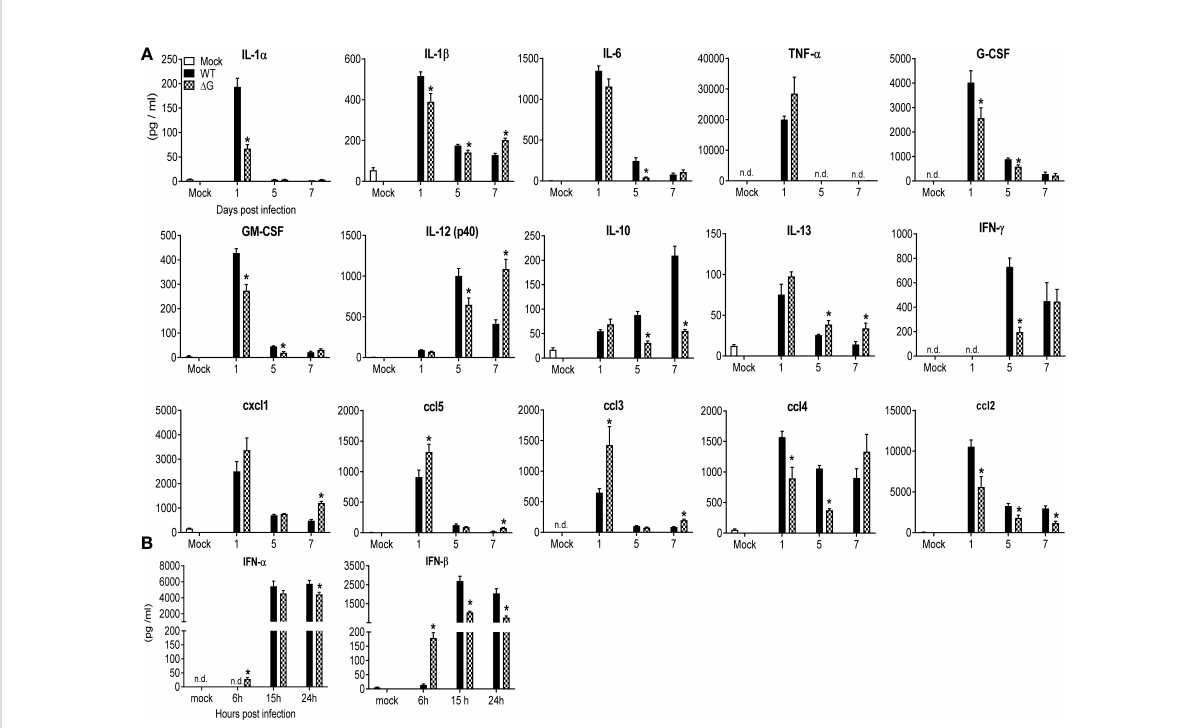
FIGURE 2 BAL fl uid levels of pro-in fl ammatory cytokines, chemokines and type I IFNs. Mice were either infected with rhMPV-WT or - D G or mock infected and sacri fi ced at various time points p.i. to collect BAL fl uid. (A) Levels of cytokines and chemokines in BAL fl uid were measured by Bio-Plex. (B) Levels of IFN- a / b were measured by ELISA. Data are expressed as mean ± SEM offour to six animals/group and is representative of one of three independent experiments. *P<0.05 when comparing rhMPV- D G infected mice to rhMPV- WT infected mice. rhMPV - D G = D G; rhMPV -WT = WT. n.d., not